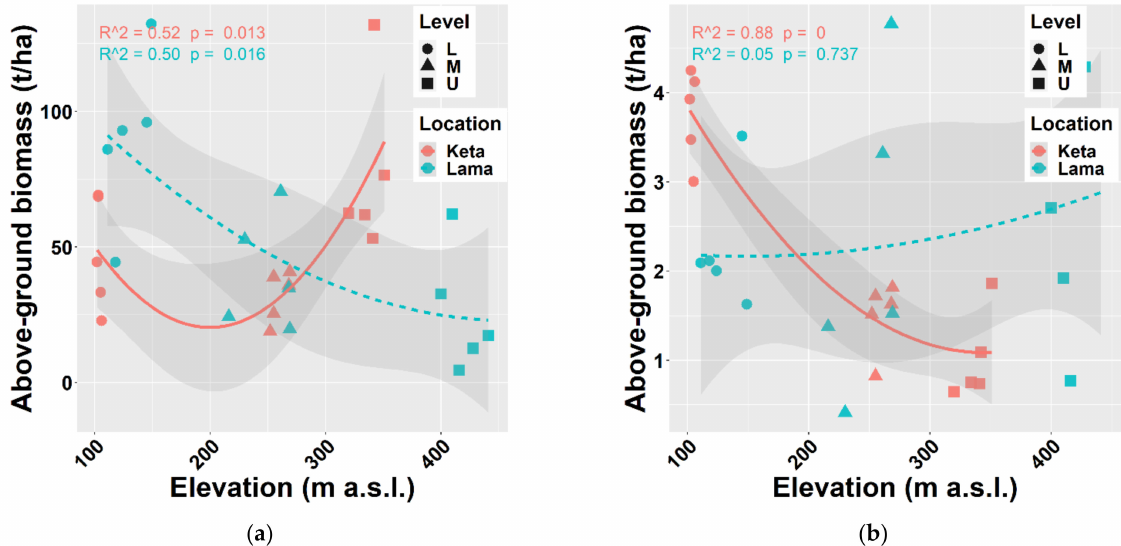
Figure 3. Relationship between elevation and aboveground living biomass ( a ) of all trees together, ( b ) of thin trees (with a height of at least 0.1 m up to DBH ≤ 7 cm) at two locations. Points represent biomass values at individual sample plots. Lines represent fitted non-linear models, and grey areas show 95% confidence intervals around the fitted models. Level: L—lower elevational zone, M—middle elevational zone, U—upper elevational